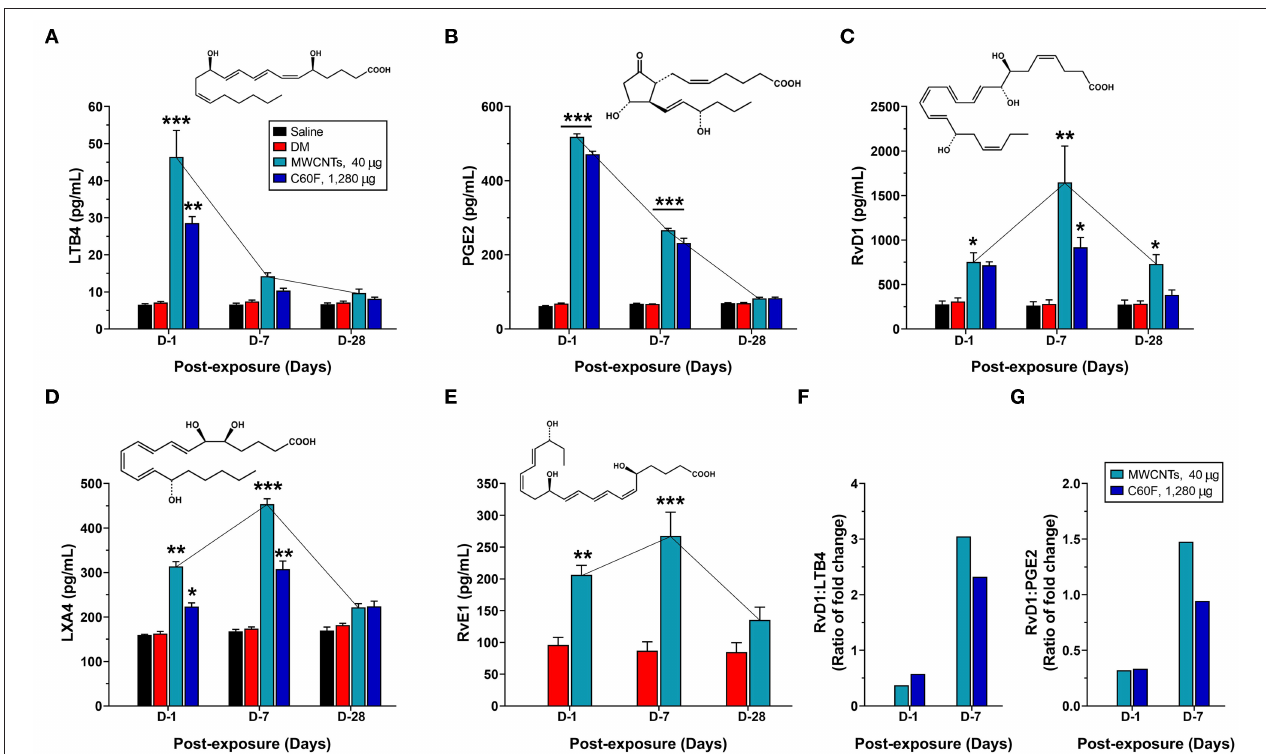
FIGURE 7 | Quantitative measurement of pro-inflammatory LMs and SPMs in mouse WLL fluids. Mice were treated as described in Figure 2 legend and were examined for the levels of specialized LMs in the WLL fluid. Proinflammatory LMs LTB4 (A) and PGE2 (B) , or SPMs RvD1 (C) , LXA4 (D) , and RvE1 (E) were quantitatively measured using ELISA ( n = 6). The ratio of fold change for RvD1/LTB4 (F) or RvD1/PGE2 (G) was further calculated for MWCNT- or C60F-treated samples at day 1 and day 7. * p < 0.05; ** p < 0.01; *** p <